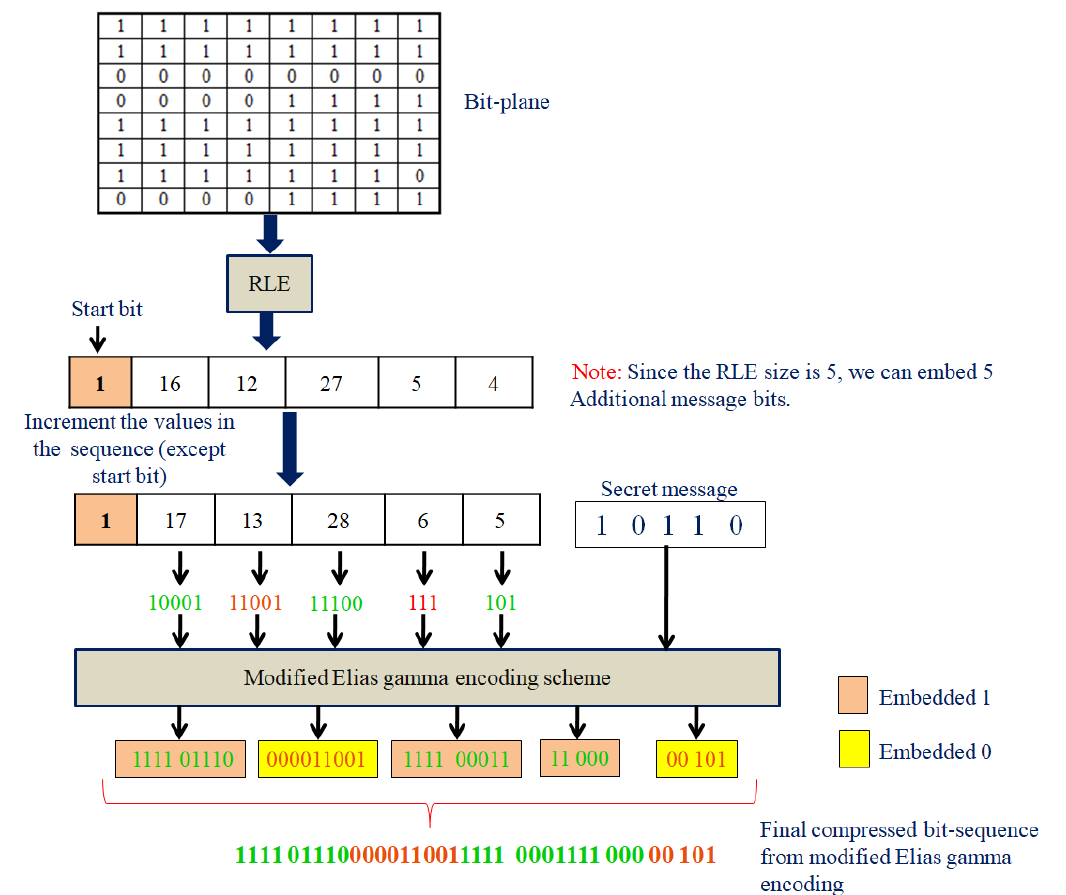
Figure 5. An illustrative example for modified Elias gamma